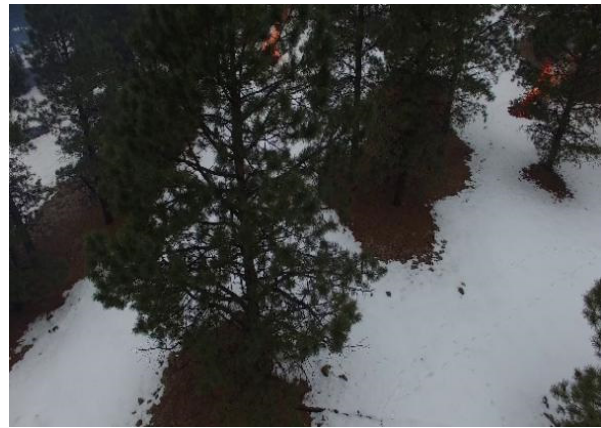
Figure 14. Result detected with EfficientDet.